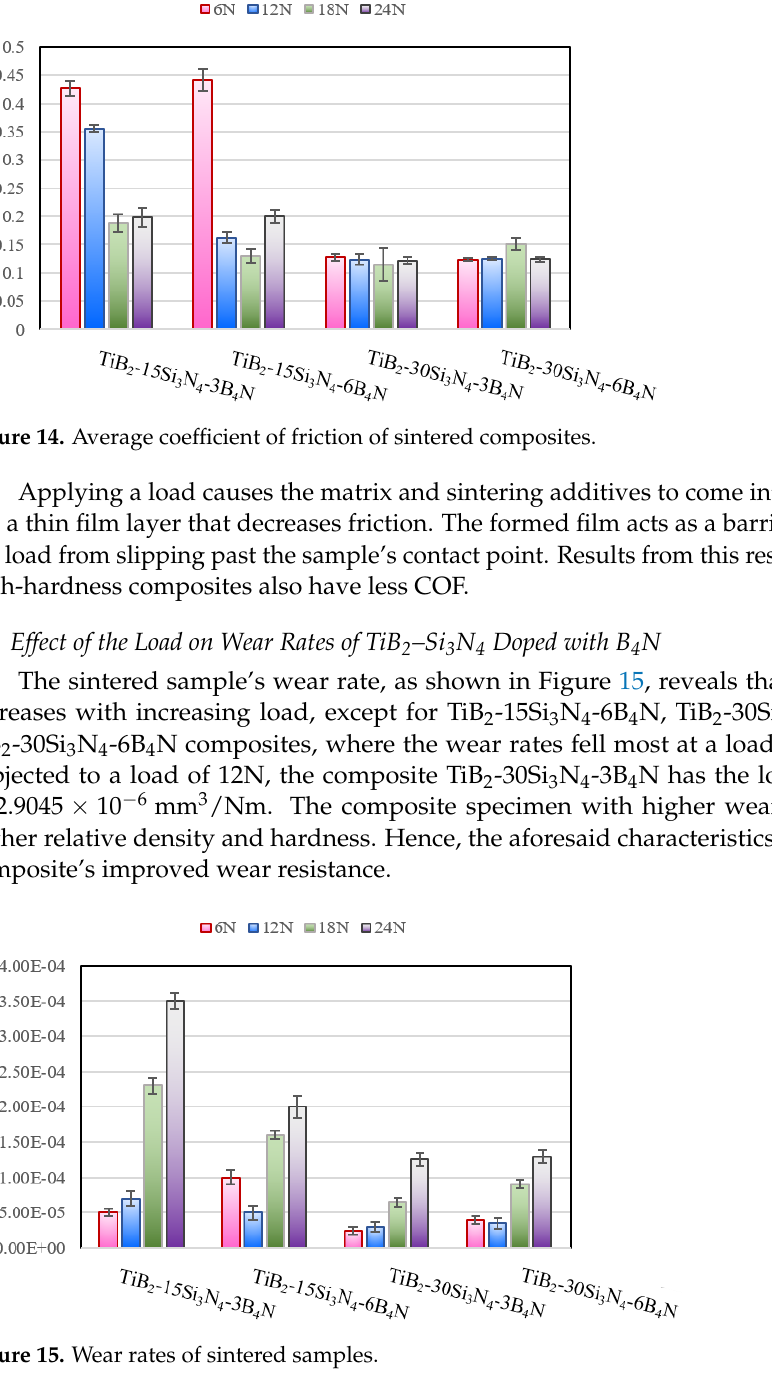
Figure 15. Wear rates of sintered samples.